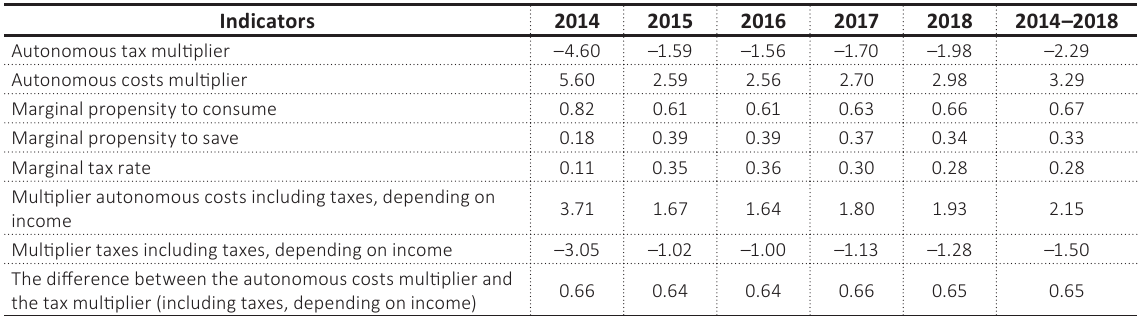
Table 3. Dynamics of marginal propensity to consume, marginal tax rate, autonomous costs multiplier and taxes in